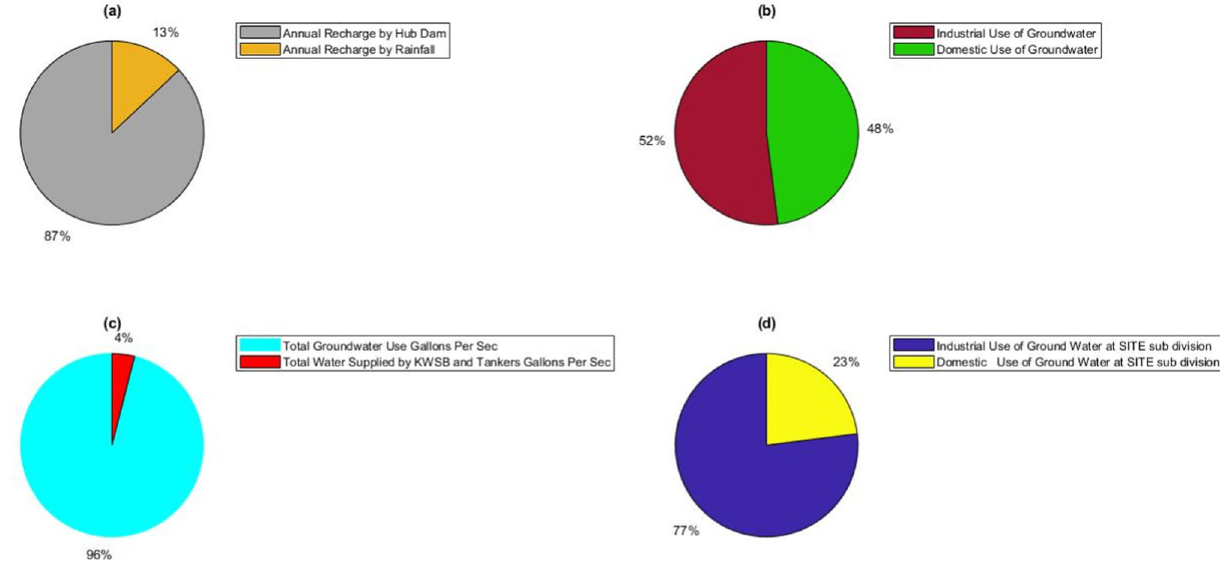
Fig. 19 a Comparison of groundwater recharge by Rainfall and Hub Dam. b Groundwater usage percentage for industrial and domestic purposes from understudy formations. c Water provided by KWSB